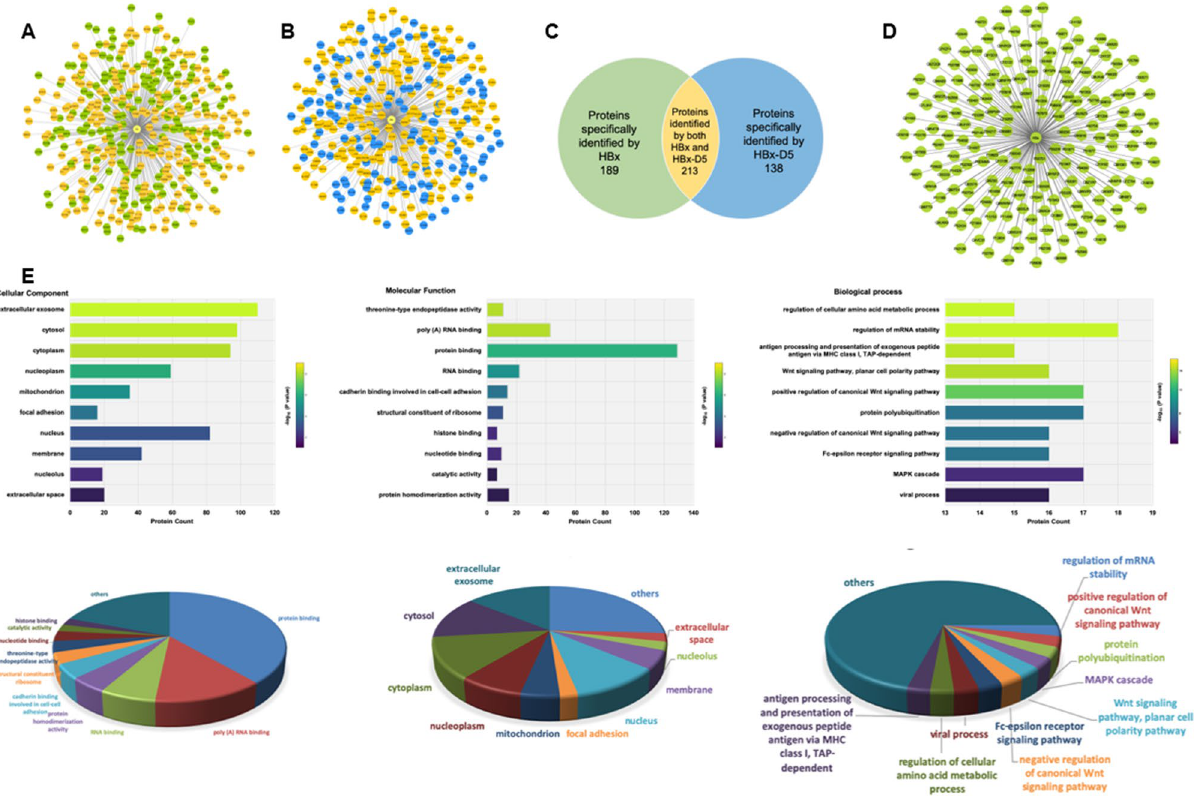
Figure 1. HBx interactome network and bioinformatic anlaysis. By comparing HBx interacted proteins ( A ) and HBx-D5 interacted proteins ( B ), proteins that specifically binds to HBx but not HBx-D5 were selected ( C and D ). Gene ontology analysis was conducted using the Database for Annotation, Visualization and Integrated Discovery (DAVID) ( E